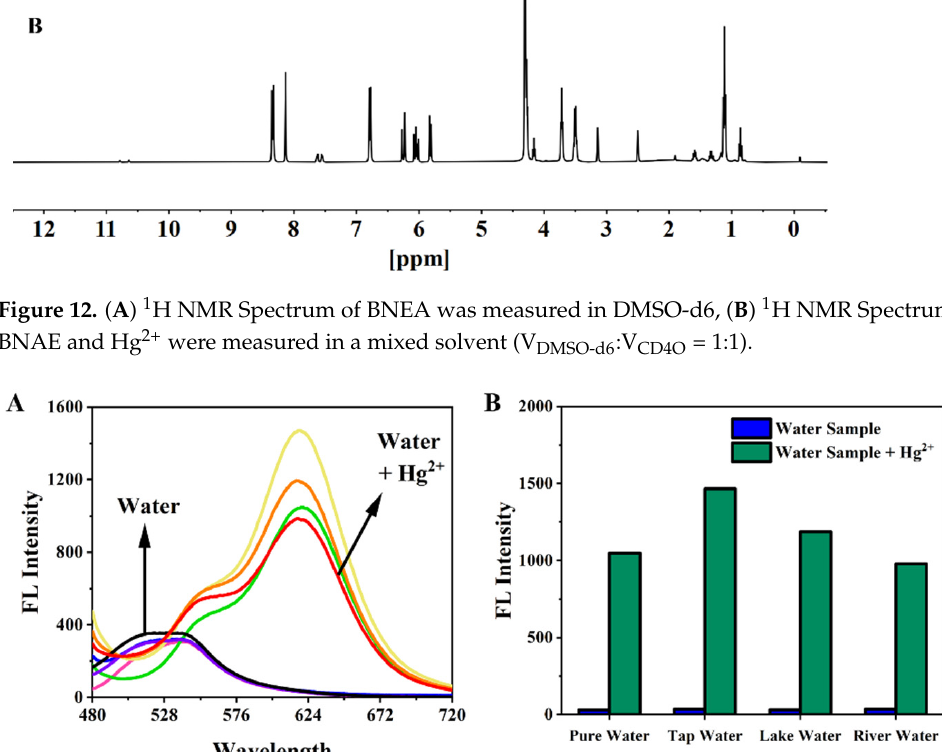
Figure 13. ( A ) Fluorescence pattern and ( B ) bar graph of mercury ion ([Hg 2+ ] = 10 µ M) detection in different types of water ( λ ex = 450 nm, [BNEA] = 10 µ M).